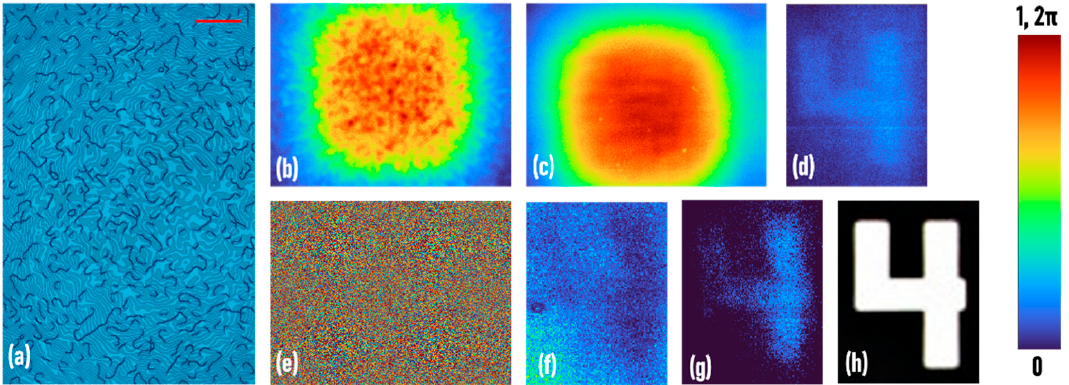
Figure 10. ( a ) Optical microscope image of the QRL. Images of the ( b ) PSH, ( c ) object hologram ( d ) reconstructed image using non-linear filter, ( e ) phase of the Fourier transform of the synthetic PSH, ( f ) edge, and ( g ) contrast-enhanced reconstructions. ( h ) Image of the object.